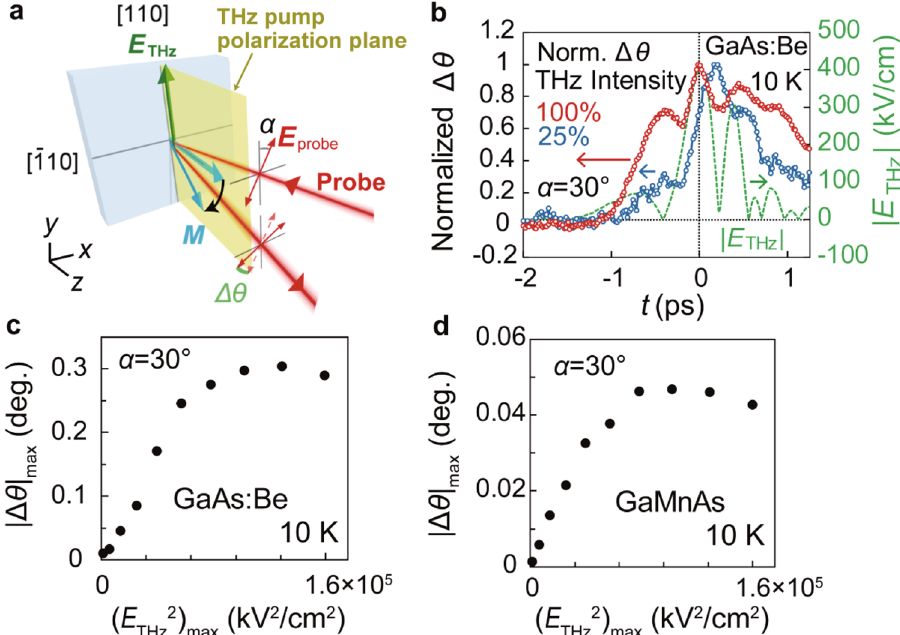
Figure 1. Overview of the experiment and the observation of Δ θ induced by the Franz-Keldysh effect. ( a ) Schematic illustration of the experimental setup. The terahertz pump pulse (yellow) is focused on the GaAs:Be or GaMnAs sample surface, and the following probe pulse with a delay time t detects the excited dynamics. Both the pump and probe pulses are linearly polarized. The strong terahertz-pump pulse with a centred frequency of 1 THz, whose electric field E THz is along the [110] axis, is generated by optical rectification using a LiNbO 3 crystal. The incident angle of the probe pulse is tilted by 10° from the sample normal towards the in-plane [110] axis. The magnetization (pale blue arrow) is tilted from the sample normal by the terahertz pump pulse. The angle of the probe polarization plane from the [110] axis towards the [110] axis is defined as α . ( b ) Time evolution of Δ θ (red circles) measured at 10 K without an external magnetic field for GaAs:Be when applying E THz expressed by the green dotted curve. Δ θ is normalized by its maximum value. The blue circles express Δ θ when the intensity E THz2 of the terahertz pump pulse is 25% of the green dotted curve ( i.e ., the maximum E THz is 200 kV/cm). α is set to 30°. ( c , d ) Maximum value of the time evolution of | Δ θ | obtained for GaAs:Be ( c ) and GaMnAs ( d ) plotted as a function of the maximum value of E THz2 at 10 K. These measurements are carried out without an external magnetic field when α is set to